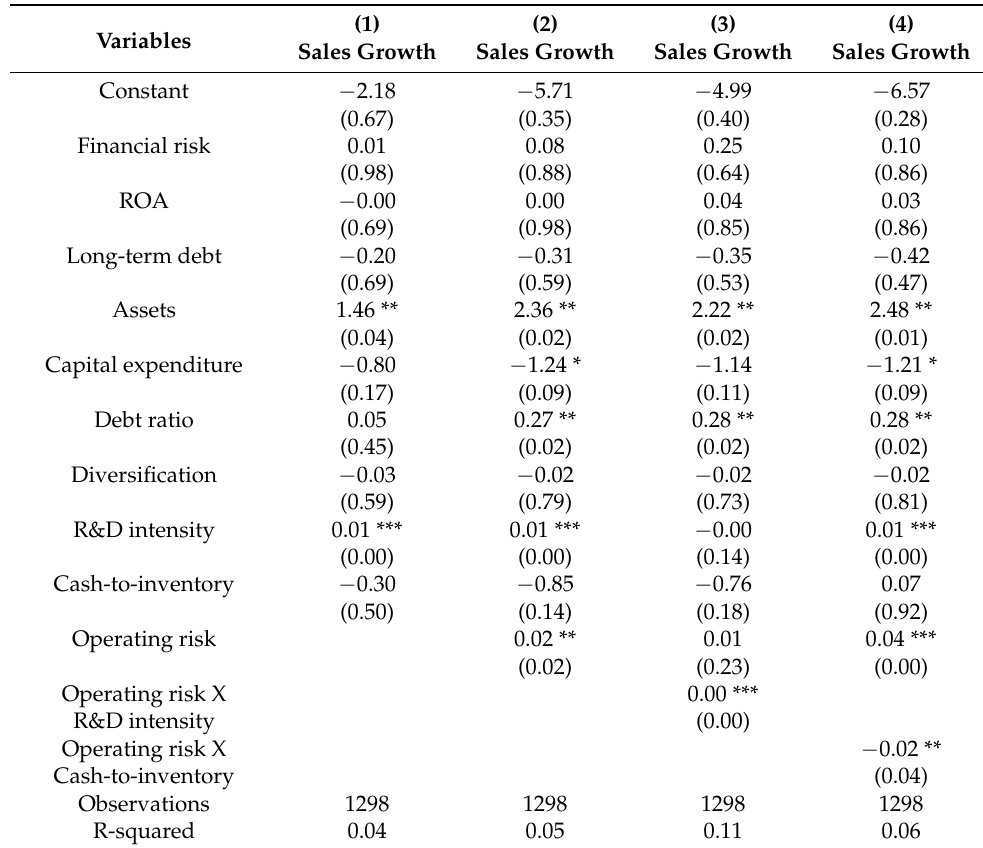
Table 3. Robustness check #1—Controlling for industry fixed effects using SIC 3-digit code.